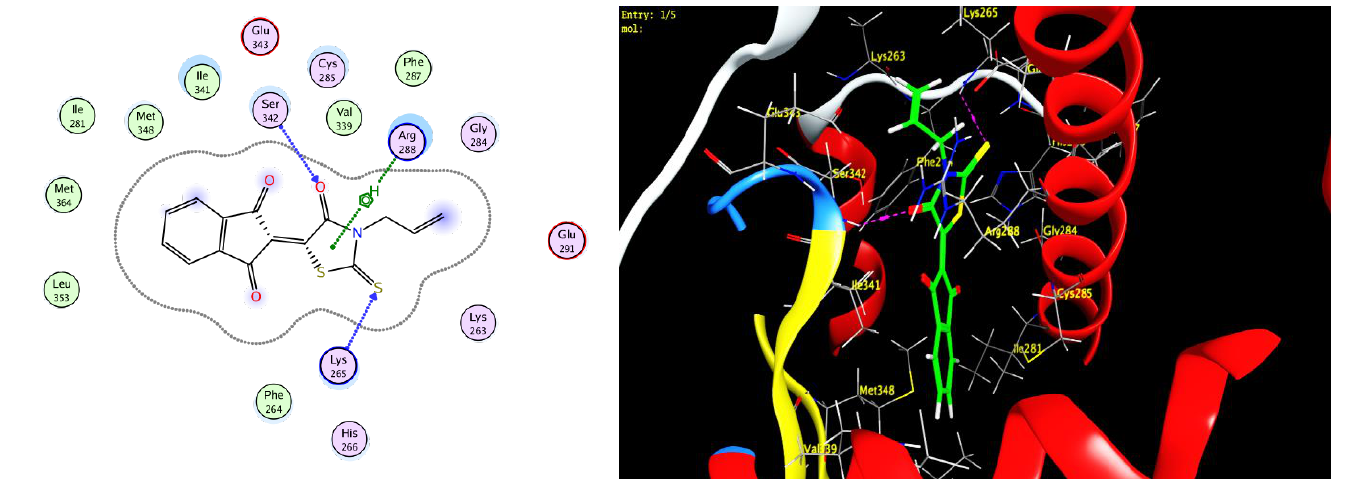
Figure 7. 2D and 3D docking of compound 5d with PPAR γ .